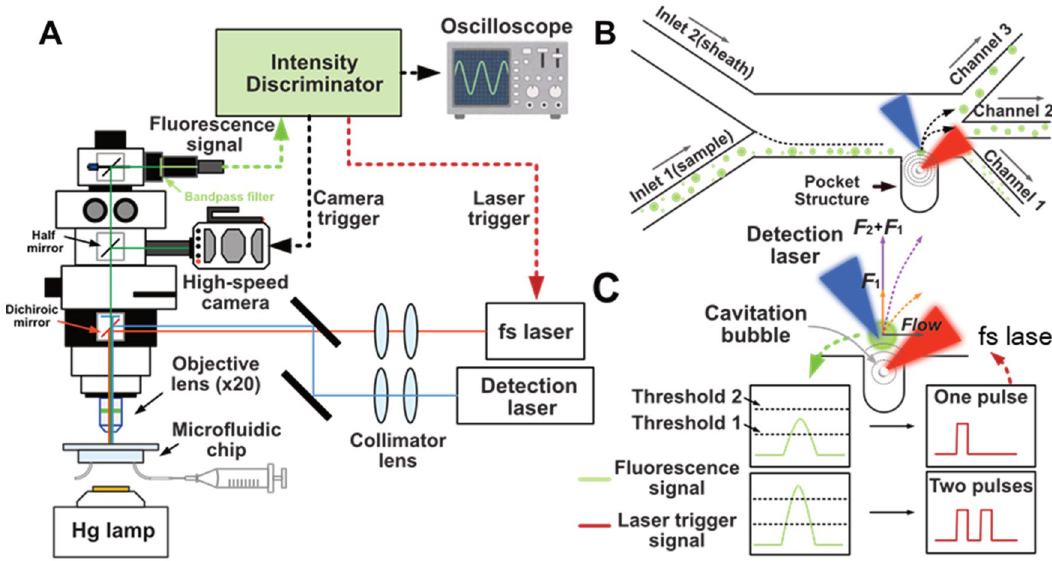
Figure 1. Schematic of the femtosecond-laser-assisted triple-selective system. Micro-objects are subjected to the impulsive force generated by the femtosecond laser (fs laser) and sorted to distinct channel